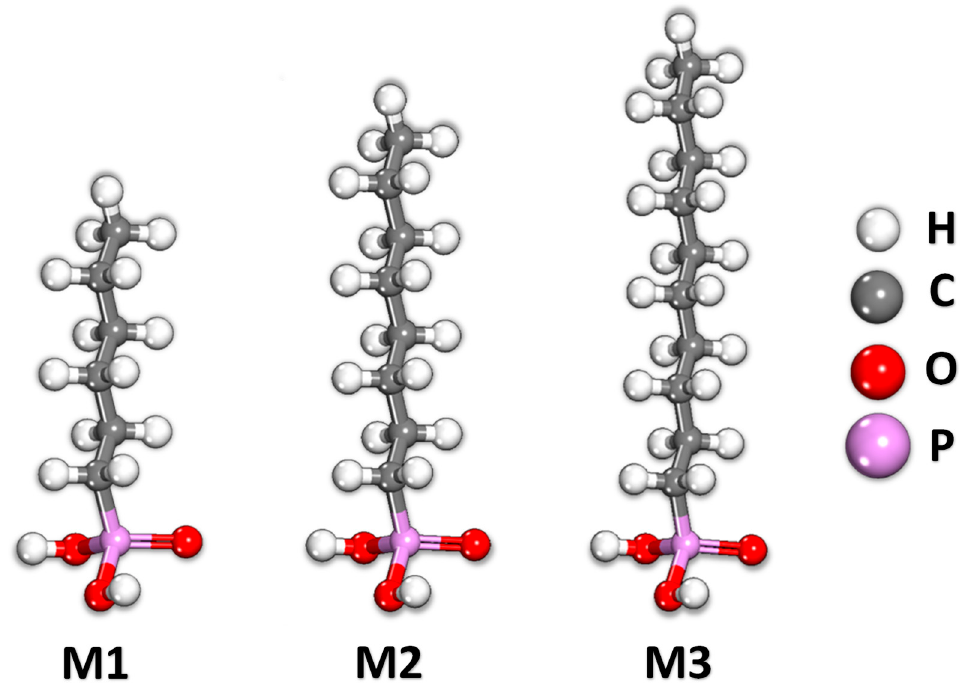
Figure 1. Structures of M1: hexylphosphonic acid, M2: octylphosphonic acid and M3: decylphosphonic acid used as in.